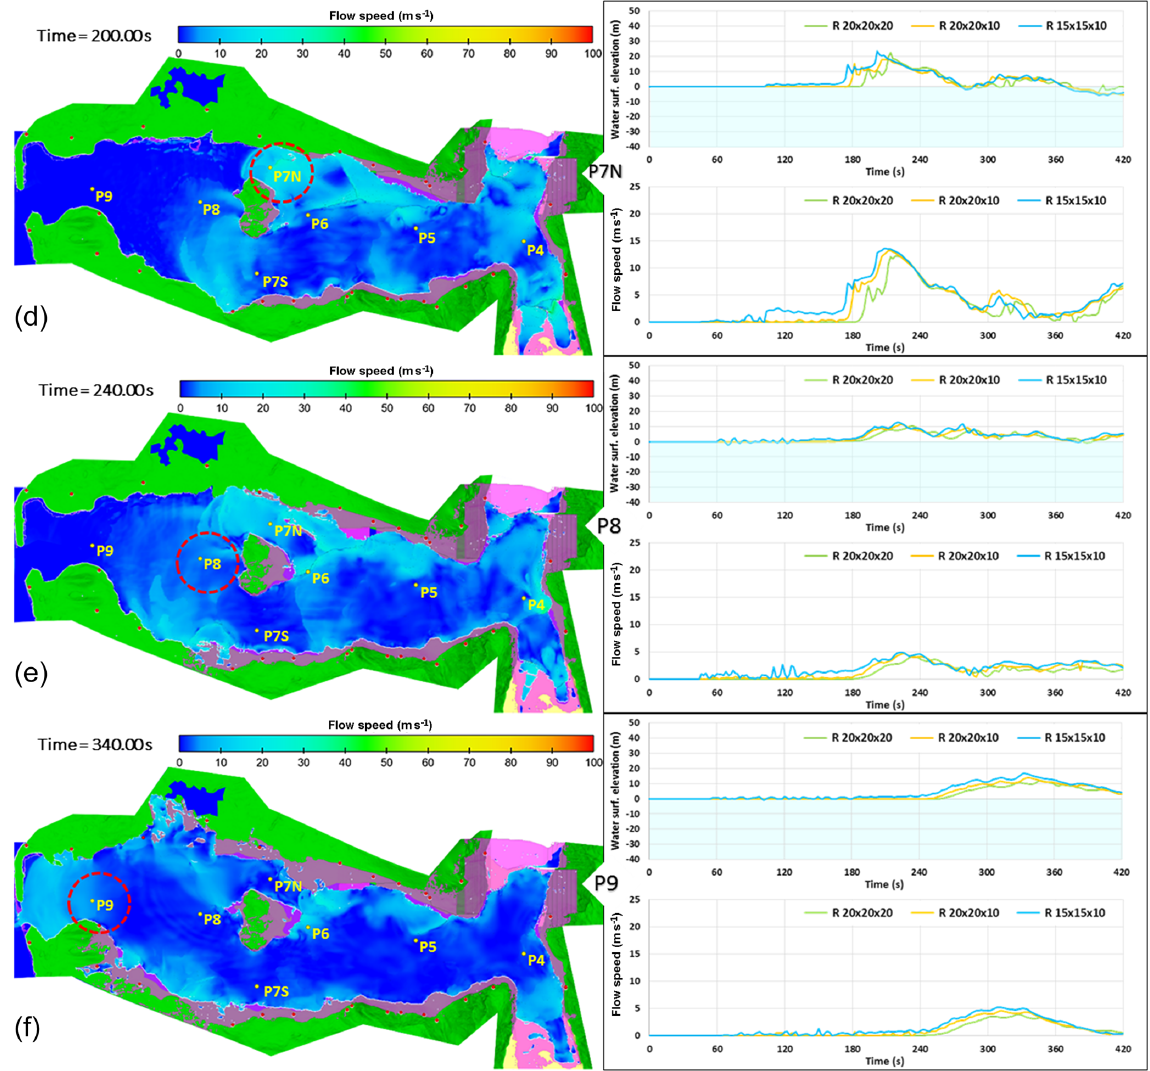
Figure 10. After the fluid impacts into the sea, the wave propagates and floods the inner land along the bay. The images show the flow speed at (a) 40s, (b) 70s, (c) 140s, (d) 200s, (e) 240s, and (f) 340s. Different observation gauges are set to check the wave attenuation during wave propagation. The trend of the water surface elevation and flow speed are shown in the graphs for the related observation gauge, adopting different non-uniform grid resolutions (R: 20m × 20m × 20m, 20m × 20m × 10m, and 15m × 15m × 10m). The purple colour of the inland are represents the inundated areas when the wave propagates (the simulation video is listed in the Data Availability section